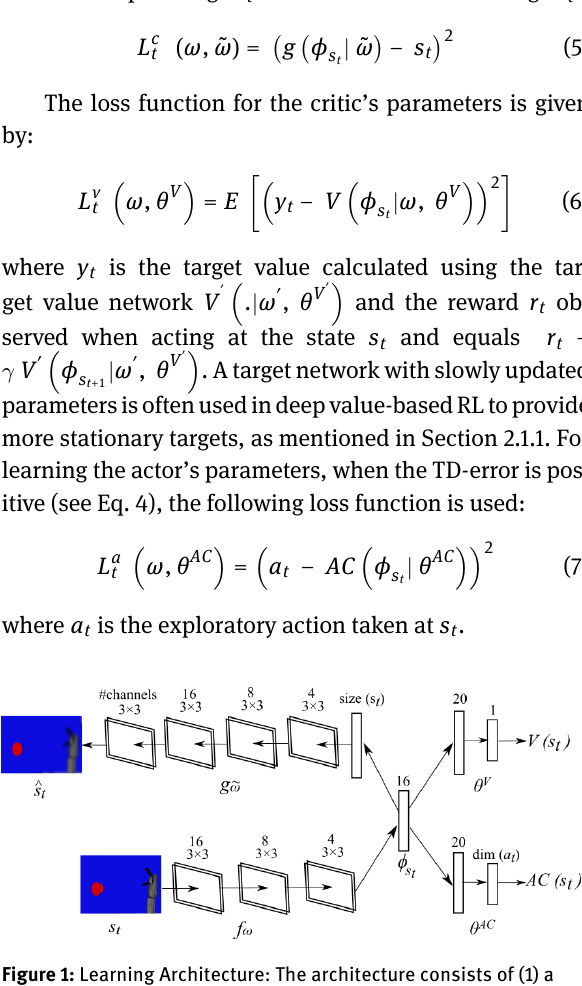
Figure 1: Learning Architecture: The architecture consists of (1) a convolutional encoder branch f ω that takes in a raw image s t and extracts a feature vector ϕ s , (2) a convolutional decoder branch g ω t that produces a reconstruction s t of the input, (3) a value branch features ϕ s , and (4) a policy branch AC with parameters θ AC that t outputs a current estimation of the best action.